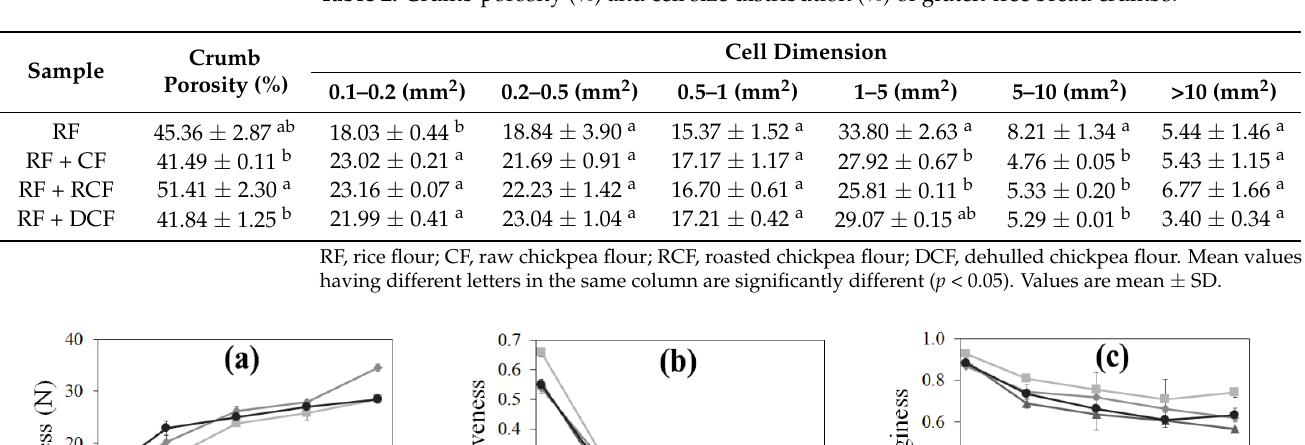
Table 2. Crumb porosity (%) and cell size distribution (%) of gluten-free bread crumbs.